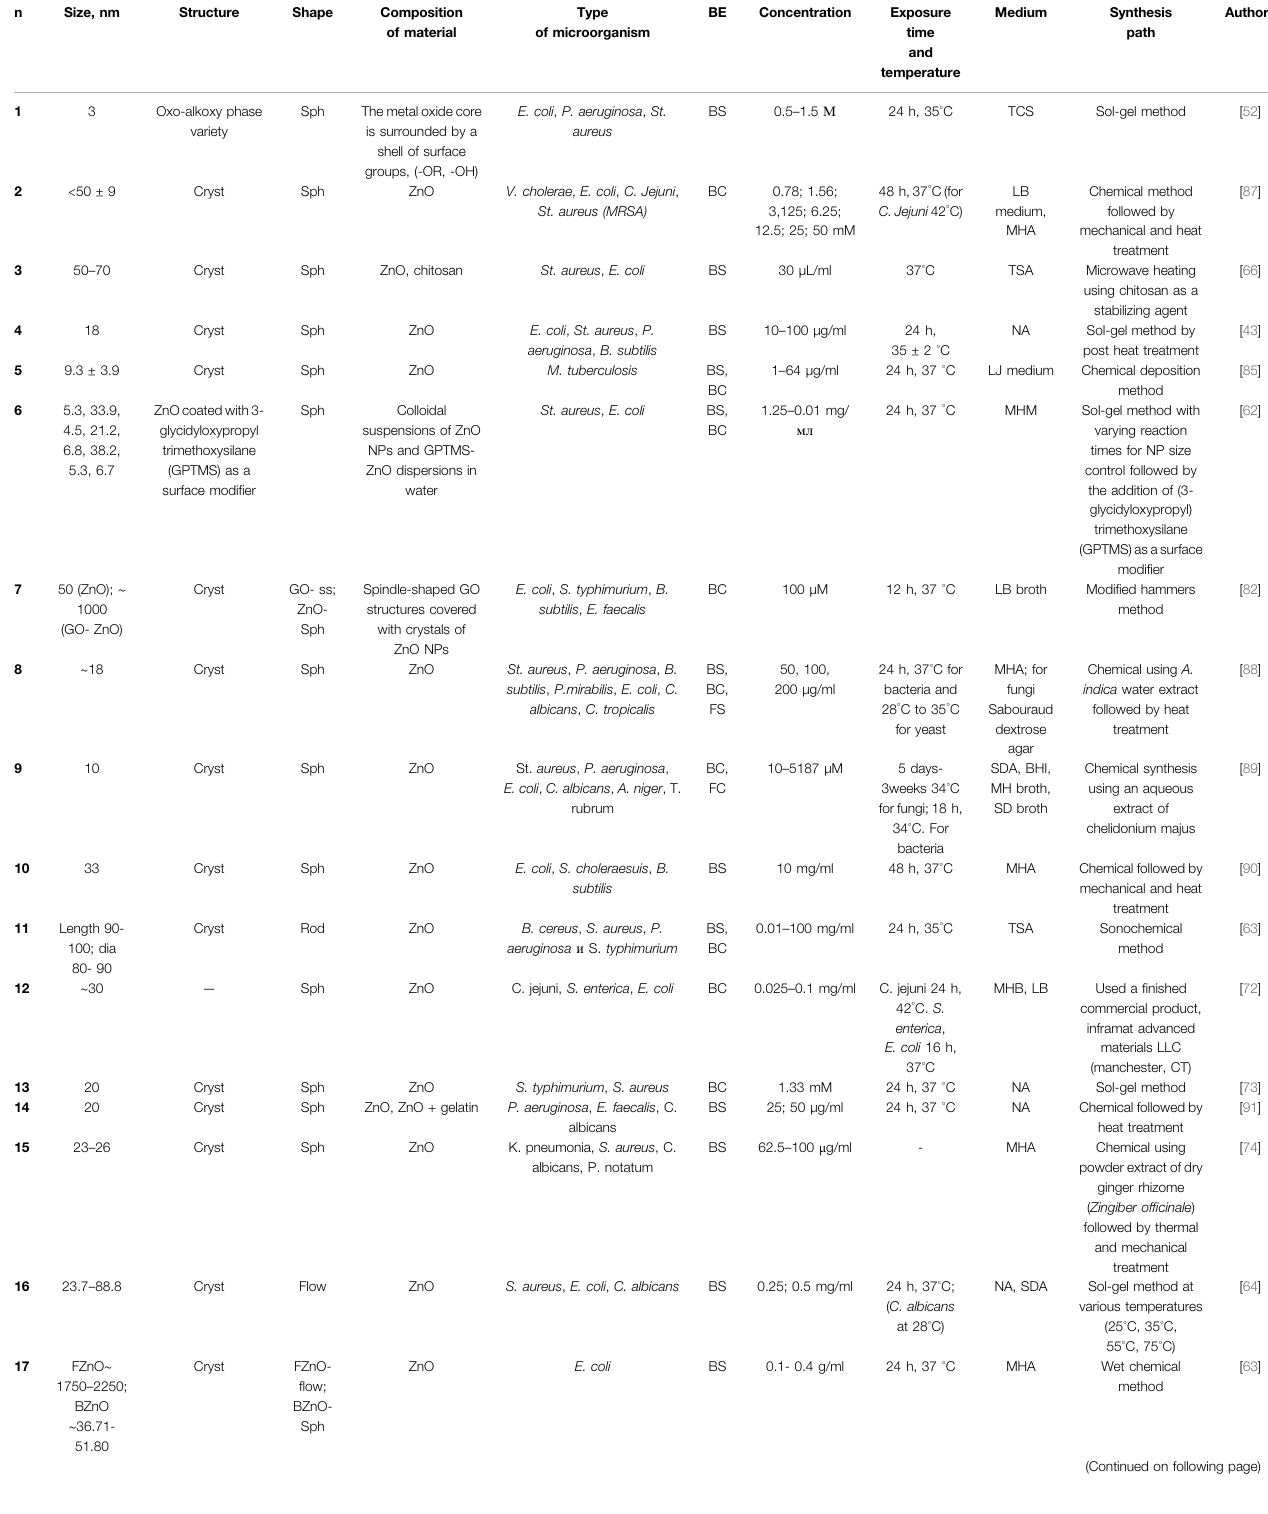
TABLE 1 | Main characteristics, physicochemical and biological parameters of ZnO nanoparticles presented in the review. n Size,